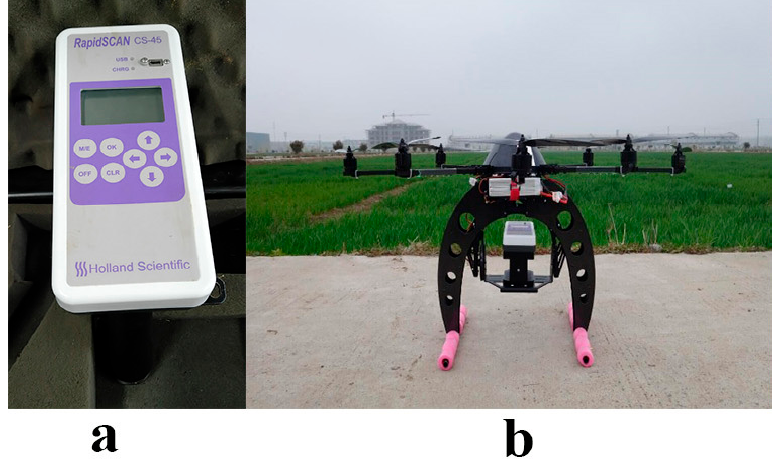
Figure 1. ( a ) The RapidSCAN CS-45 canopy sensor, ( b ) unmanned aerial vehicle (UAV) equipped with the RapidSCAN CS-45 sensor.